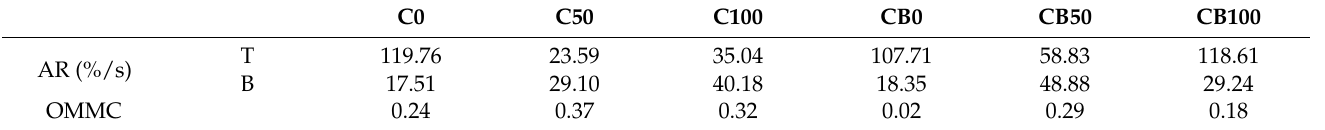
Table 6. The results of moisture management testing for cationized cotton fabric presented as mean value.